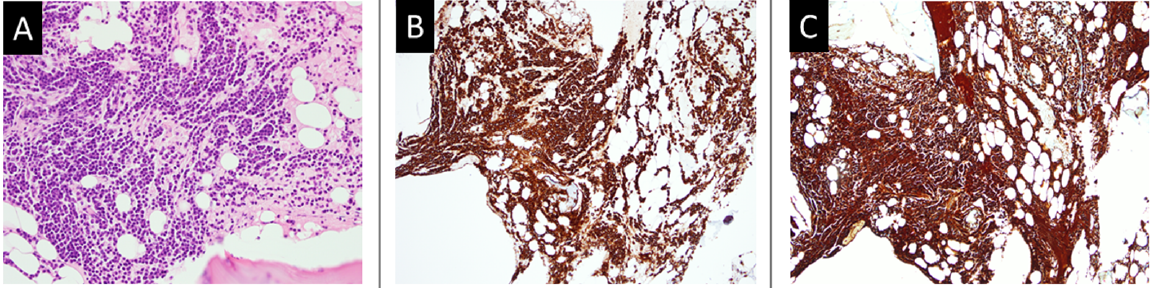
Figure 4. Histology findings of bone marrow biopsy. ( A ) Abundant plasma cells aggregate in the bone marrow tissue, replacing the normal distribution of bone marrow cells (hematoxylin–eosin staining, 100×). ( B ) CD138 immunohistochemical staining showing dark brown aggregating plasma cells (immunohistochemical staining, 40×). ( C ) The kappa/lambda light chain double staining shows a single color (brown) of the stained cells, indicating kappa light chain monoclonality. The normal polyclonality of the kappa and lambda light chains may show two colors (brown and red, usually presenting kappa and lambda chains, respectively). The normal ratio of kappa cells and lambda cells is usually 2:1 (immunohistochemical staining, 40×).